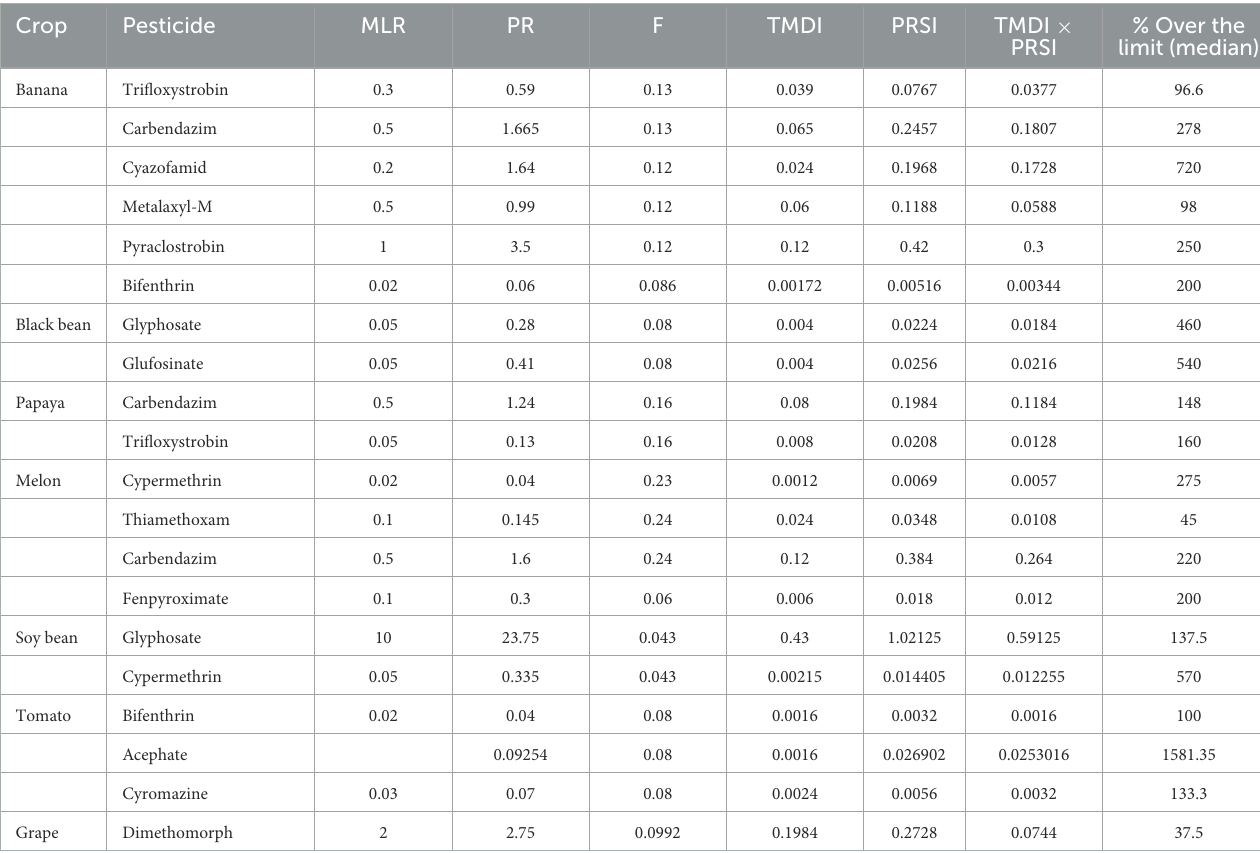
TABLE 2 Pesticide active substances percentages applied over the limit in agricultural crops according with TMDI and PRSI values in 2019. Crop